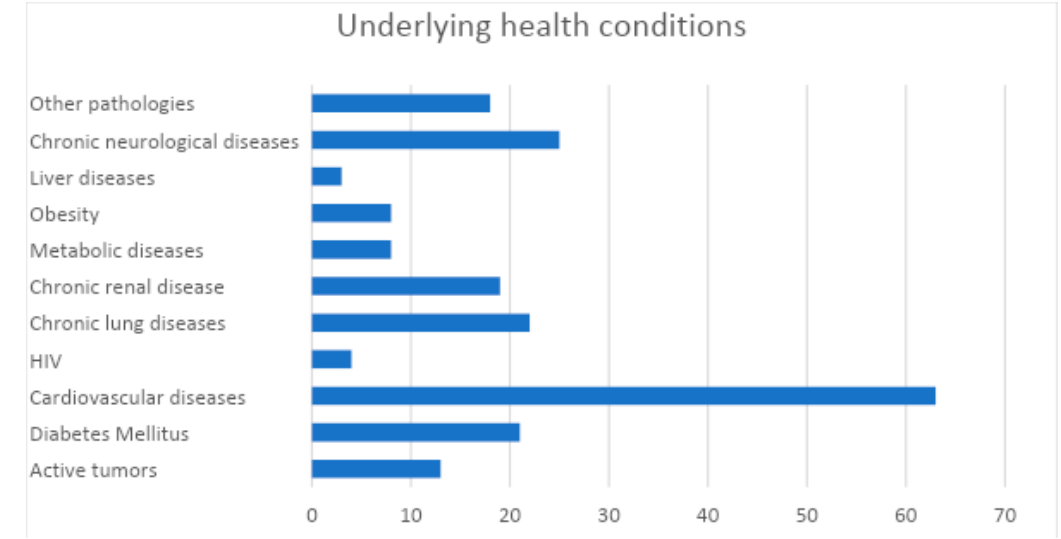
Figure 1. Underlying health conditions of the 90 deceased patients with SARS ‐ CoV ‐ 2 in Sardinia.